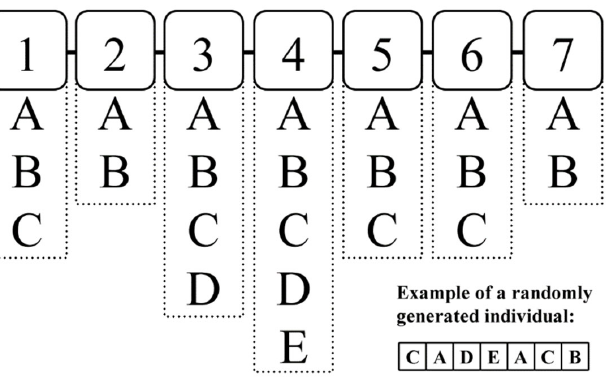
Figure 5. Example of a chromosome with 7 genes (or products) and a randomly generated individ ‐ ual.